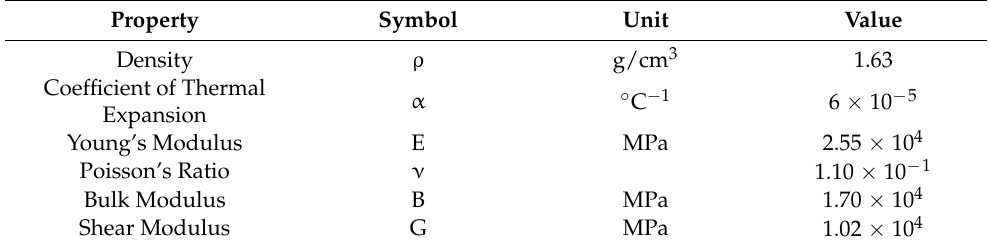
Table 2. The physical and elastic properties of electronic component material.